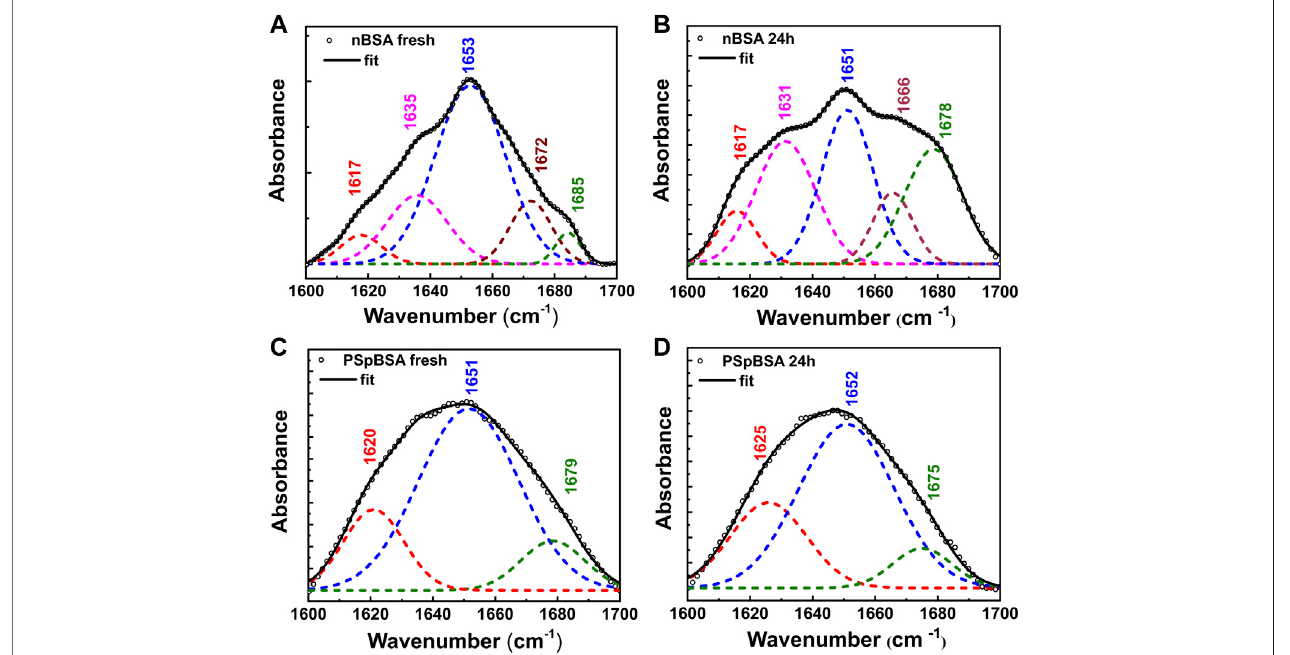
FIGURE 3 | Secondary structural changes of nBSA and PSpBSA monitored by FTIR spectra, in the region corresponding to the amide I band (1,600 – 1700 cm − 1 ) of fresh (A) nBSA and (C) PSpBSA solutions, and (B,D) after heating them at 65 ° C for 24 h. The open symbols represent the experimental values, whereas the black solid line shows fi ts to the experimental data. The dashed lines show the different components, obtained after Fourier self-deconvolution ( Table 1 ).